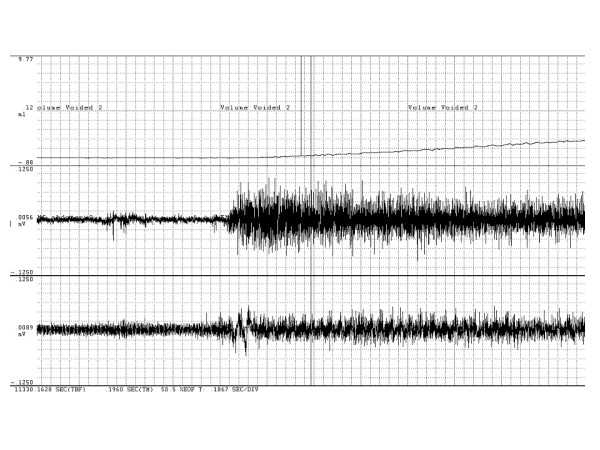
Time-expansion of voiding-associated EMG changes. Time-expanded tracings demonstrating changes in rectus abdominis and perineal EMG activity accompanying voiding. Top tracing is voided volume, middle tracing is rectus abdominis EMG, and bottom tracing is perineal EMG tracing. Pulse width of perineal EMG tracing indicated by vertical lines, interval is 0.2 second.